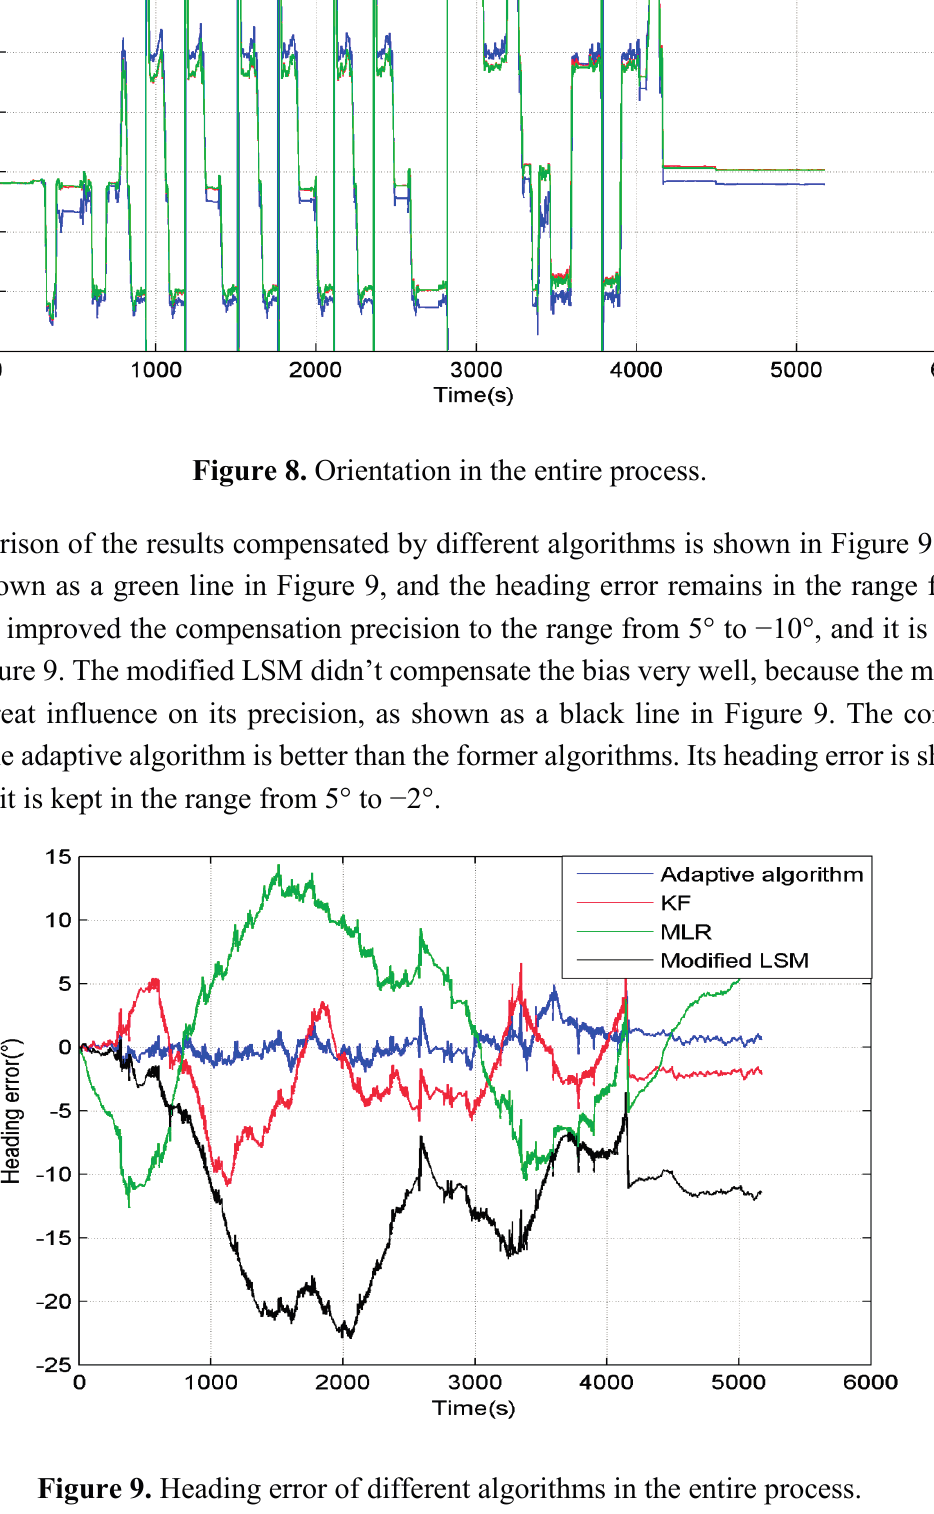
Figure 9. Heading error of different algorithms in the entire